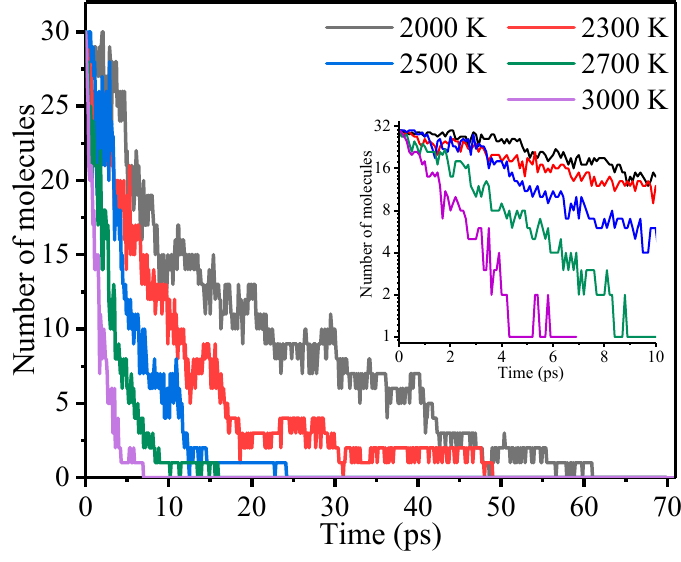
5 of 13 Figure 3. Chemical bond fracture behavior for the initial reaction: ( a ) initial model, ( b ) dehydrogenation reaction, ( c ) C aromatic ring –N bond fracture, and ( d ) C=O bond fracture. 3.2. Kinetic Calculation of Meta-Aramid Fiber Pyrolysis The variation in the number of meta-aramid fiber molecules at different temperatures is shown in Figure 4. The number of meta-aramid fibers fluctuated with the progress of thermal decomposition